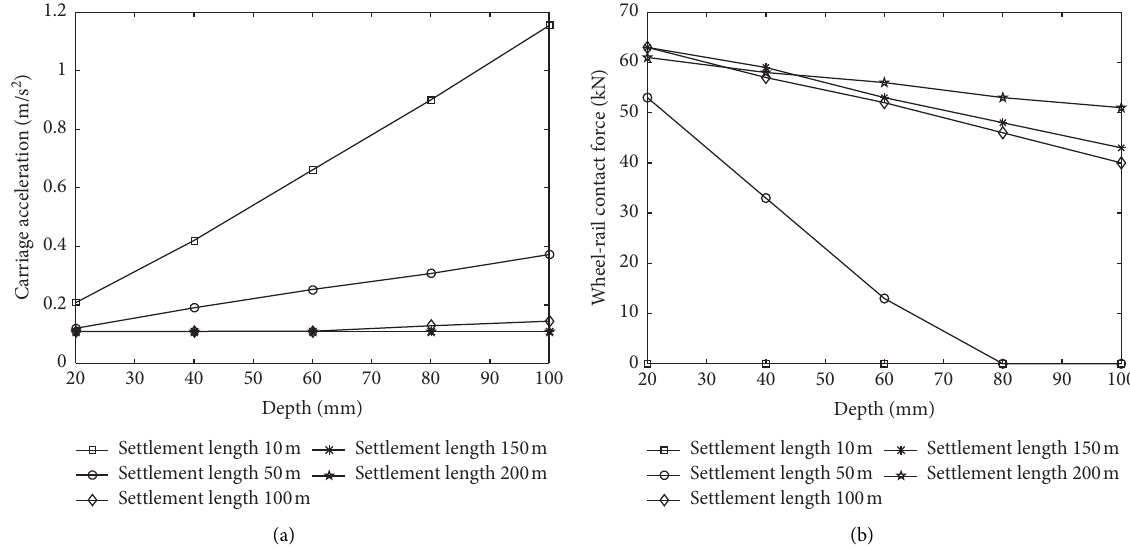
Figure 14: Metro train-track vibration under different tunnel differential settlements. (a) Maximum acceleration of the carriage. (b) Minimum wheel-rail contact force.